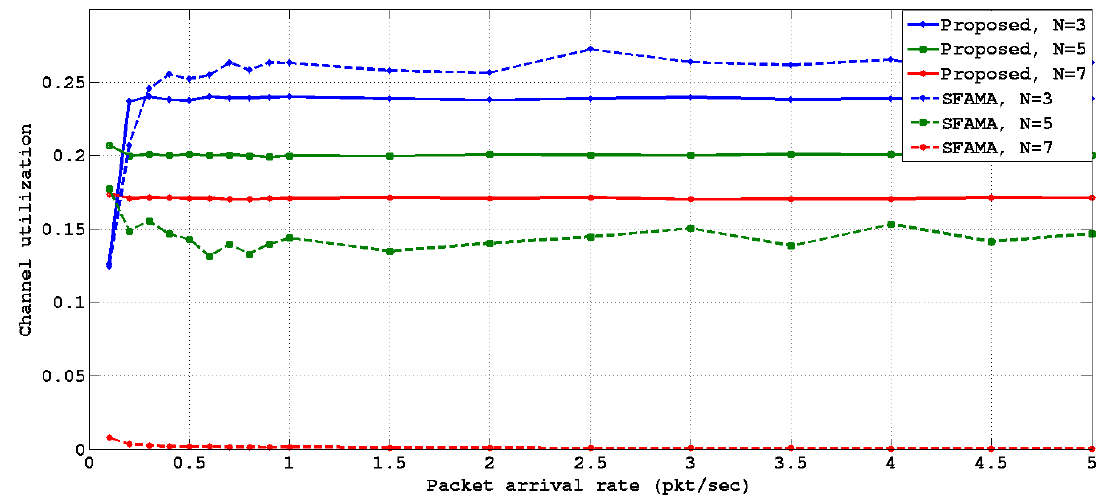
Figure 11. Comparison between slotted floor acquisition multiple access (S-FAMA) and the proposed protocol.